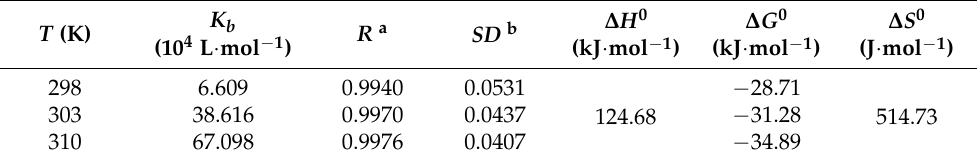
Figure 3. ( A ) Double logarithmic plots for the quenching of HSA by AgNPs at different tempera- tures; ( B ) Van’t Hoff plot for the interaction of AgNPs with HSA. Table 2. The binding constants and thermodynamic parameters of HSA/AgNPs systems at varying temperatures.